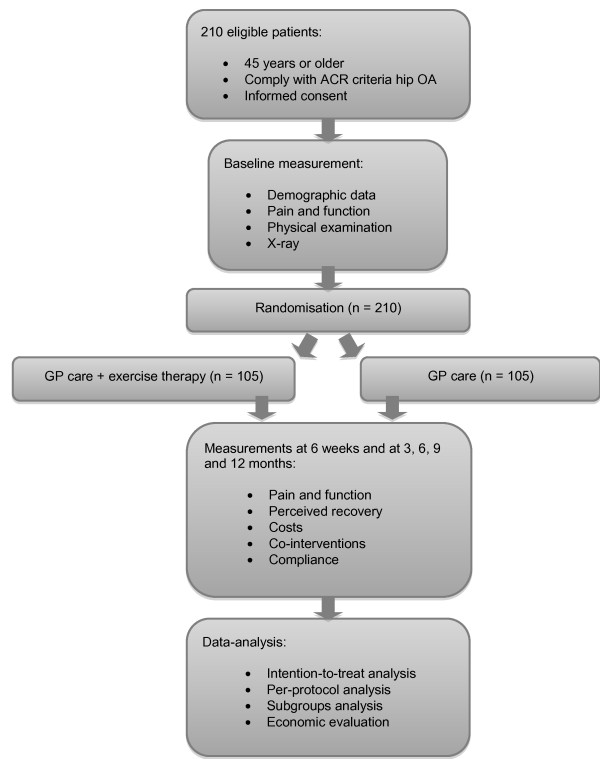
Flowchart of the study.